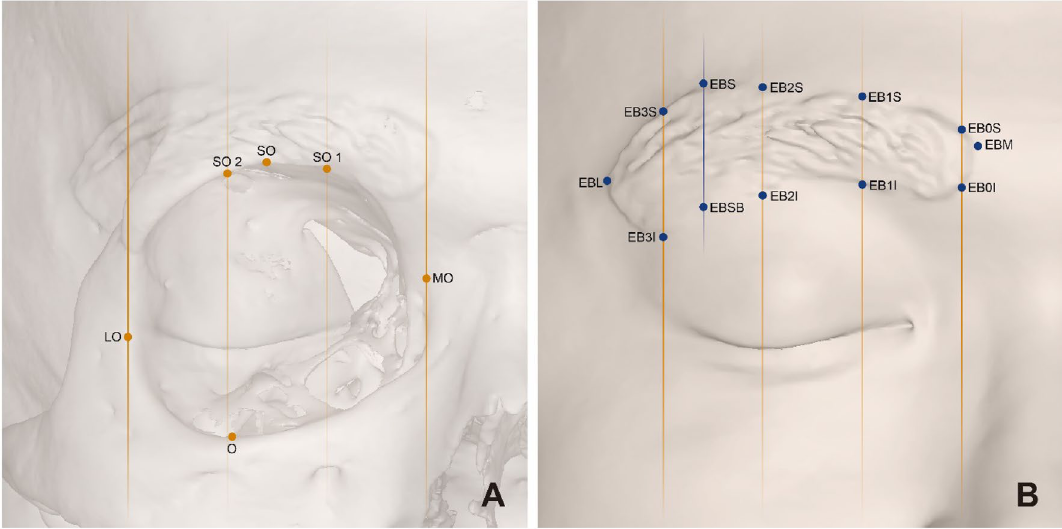
Figure 2. Anatomical landmarks of the orbit ( A ) and eyebrow ( B ). Detailed definitions of the landmarks are listed in Table 4.